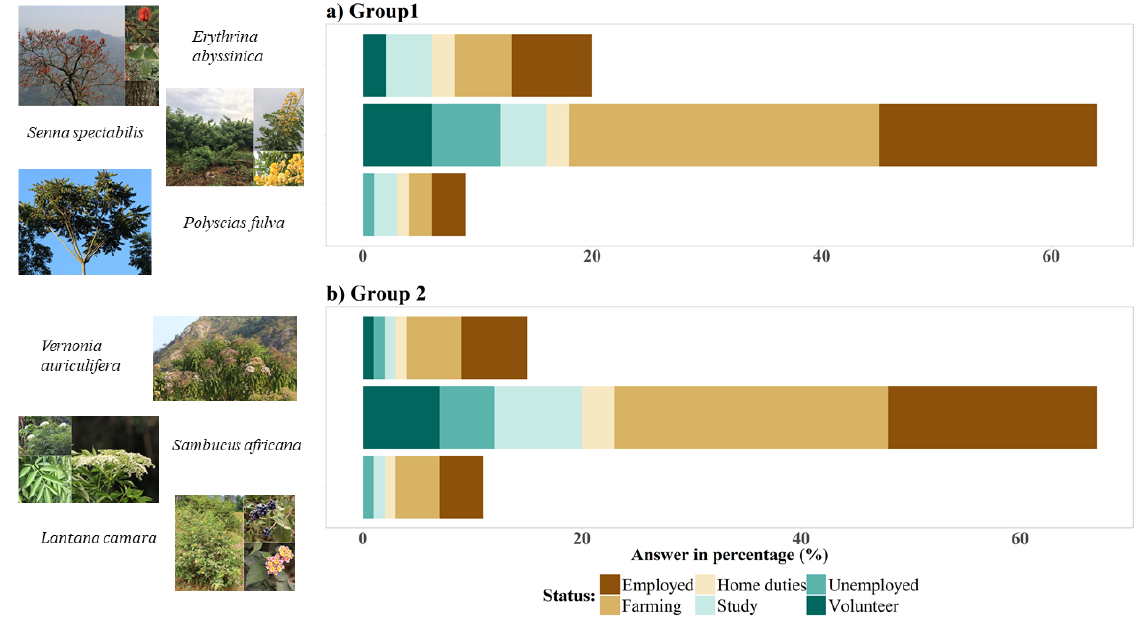
Figure 6. Results of photo survey to assess local people’s knowledge on the non-native plants, Senna spectabilis ( a ) and Lantana camara ( b ). Plot shows answers to the following question: “Which of the following species in Group 1 and 2 is not native to Uganda?”.